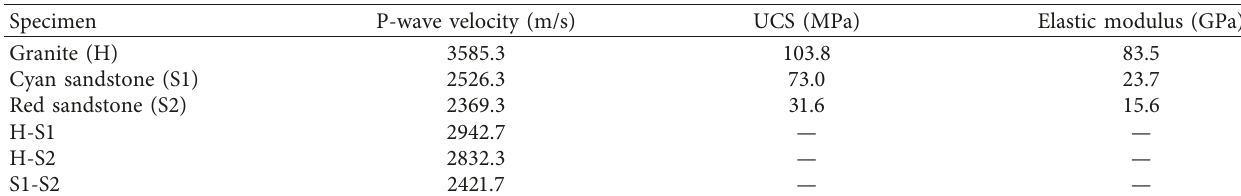
Figure 2: Photographs of test samples and mineral composition; (a) granite, cyan sandstone, and red sandstone samples; (b) composite samples; and (c) mineral composition and relative content. Table 1: Physical and mechanical parameters of the